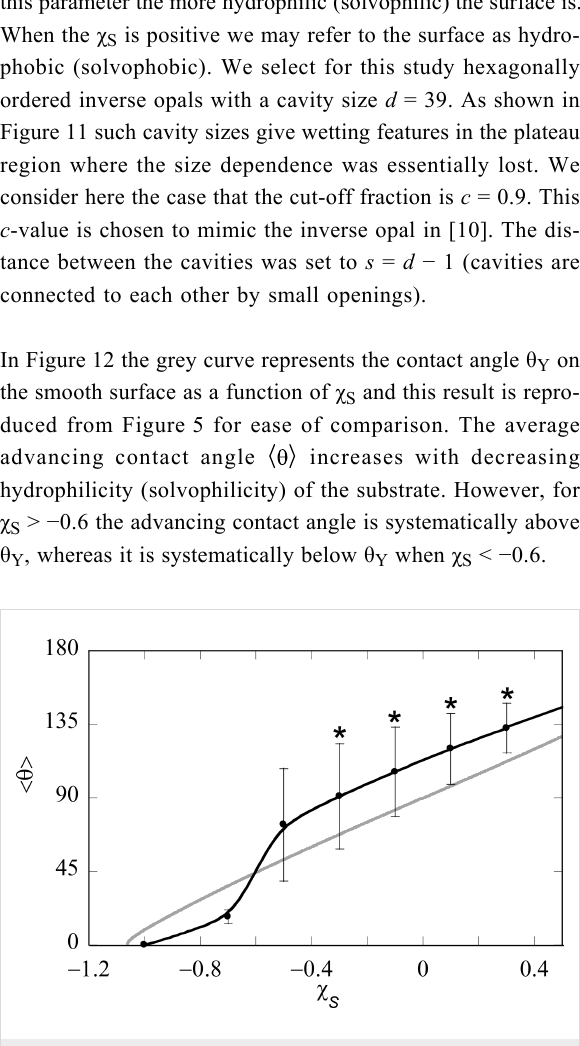
Figure 12: Advancing contact angle and the corresponding fluctu- ations (measured along the x -direction) indicated as error bars, as a function of the affinity of the solvent for the substrate phase χ S for a hexagonal inverse opal with cavity sizes d = 39, cut-off fraction c = 0.9 and spacing between the cavities s = d − 1 = 38. The contact angle on a smooth surface is shown with a grey line (copied from Figure 4). Stars indicate that the cavities under the water front remain empty (Cassie–Baxter wetting state).